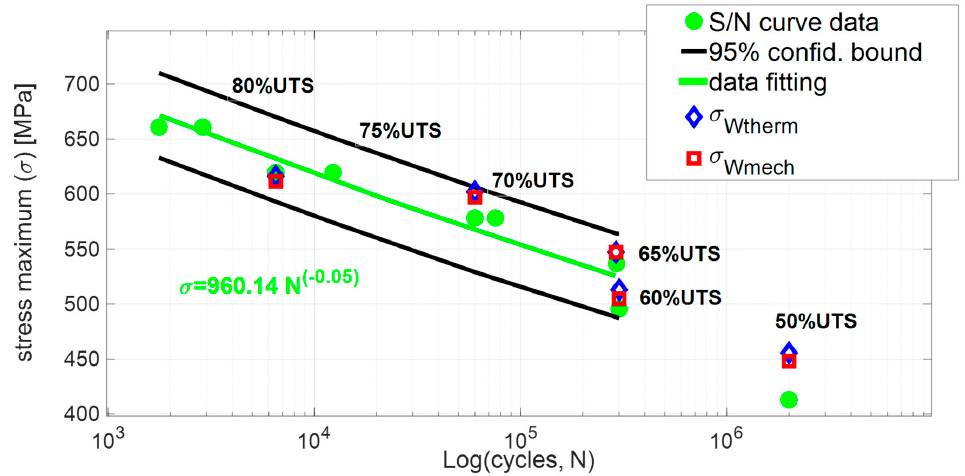
Figure 10. Stresses assessed σ Wmech (red marker), σ Wtherm (blue marker) by using the W mech , W therm data compared to S/N imposed stresses (green marker).